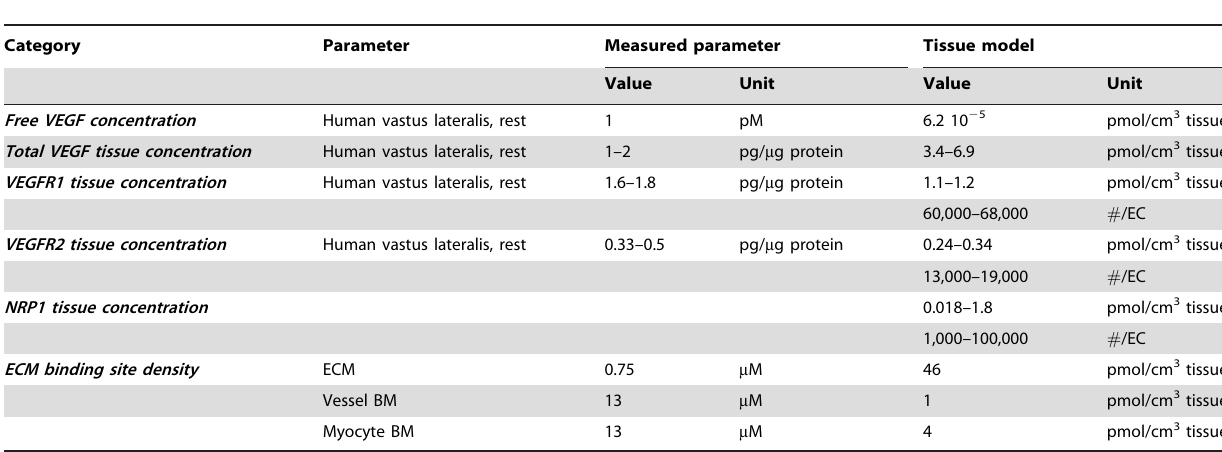
The conversion of receptor densities to tissue: see table 2. Endothelial cell surface area=1000 m m 2 . Conversions are as follow: VEGF concentration: 6.2 10 7 (pmol/cm 3 tissue)/M (here, M=moles/liter interstitial fluid available to VEGF); VEGF binding sites in the ECM and BMs: 6.2 10 7 (pmol/cm 3 tissue)/M (ECM fluid accessible to